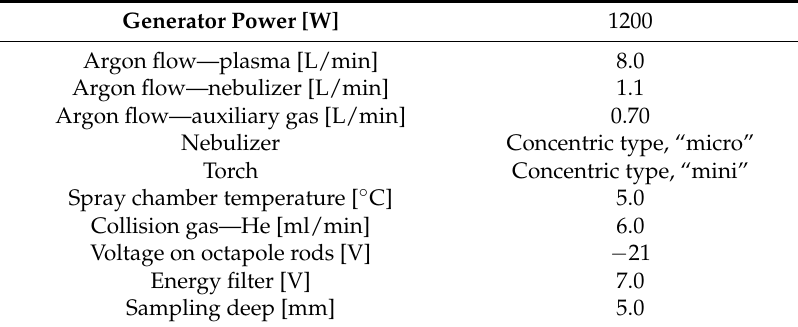
Table 6. ICP-MS parameters for analysis of HCl and H 2 O 2 /HNO 3